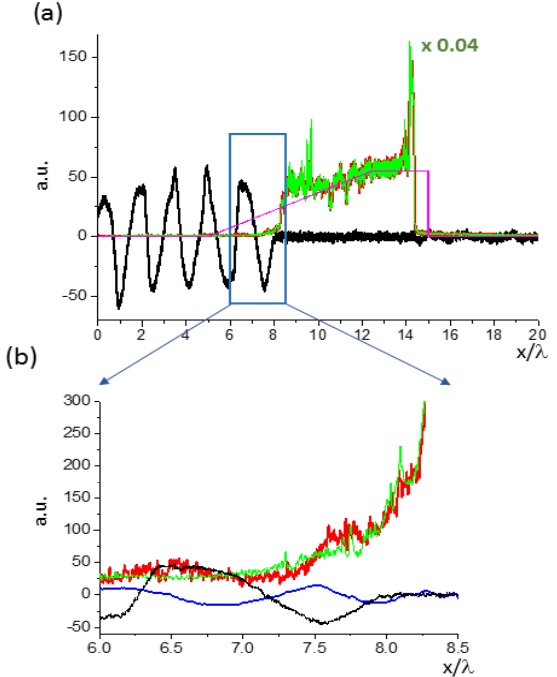
Figure 7. PIC simulations of the interaction of a 600 fs pulse of the intense (2.7 × 10 21 W/cm 2 ) linearly-polarized laser radiation with the Si 14 plasma layer. The general view of the laser-target interaction at the instant t = 320 fs from the beginning of the interaction ( a ) and the zoom ( b ) on the area shown by the blue rectangle in ( a ). The coordinate x is in units of the laser wavelength λ . The initial scaled density profile is presented by the violet line. The scaled electron and ion densities are presented by the red and green lines. They are given in the units of 0.04 ZN cr in ( a ) and in the units of ZN cr in ( b ); here N cr = γ N c , where N c is the critical plasma density and γ is the relativistic factor. The calculated scaled transversal electric field a L = eE L /( m e ω L c ) is shown by the black line and the longitudinal one (the Langmuir wave) a l = eE l /( m e ω L c )—by the blue line